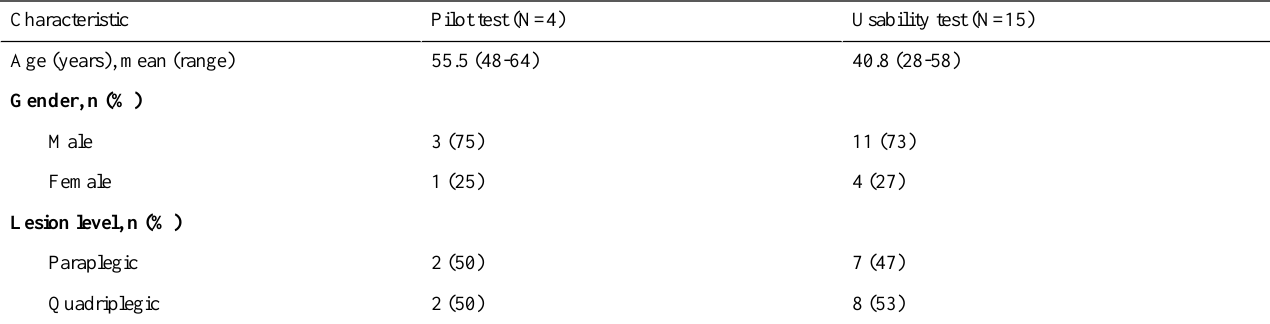
Table 2. Characteristics of study participants in Phase